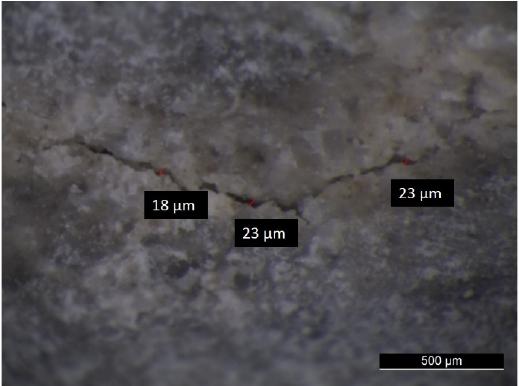
Figure 5. Microscopic image of the exposed surface on a cracked specimen after six months of exposure to ponding.